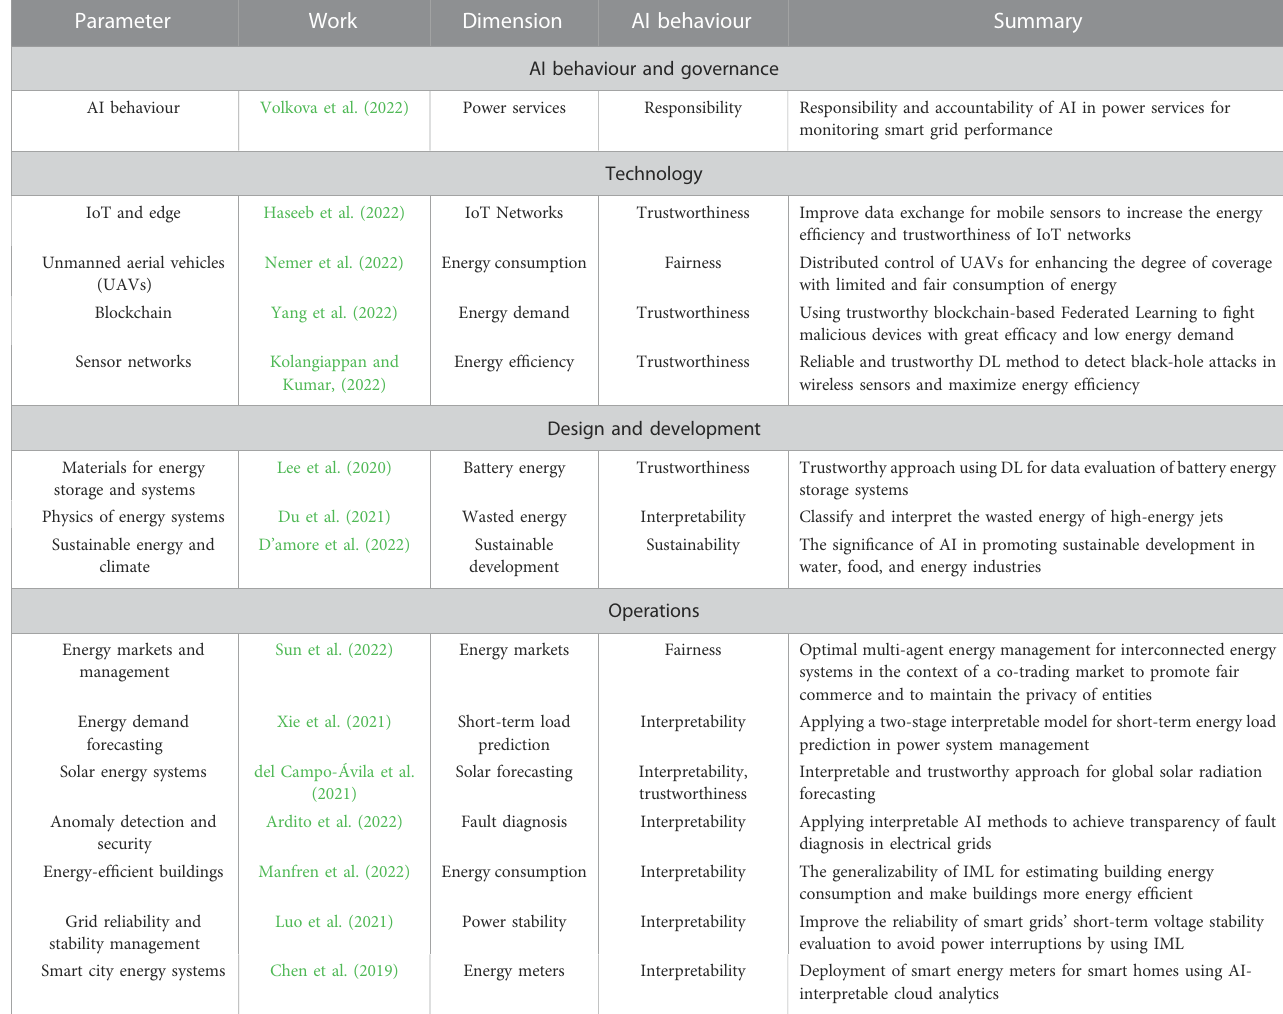
TABLE 1 AI explainability and governance in smart energy systems: Parameters and example